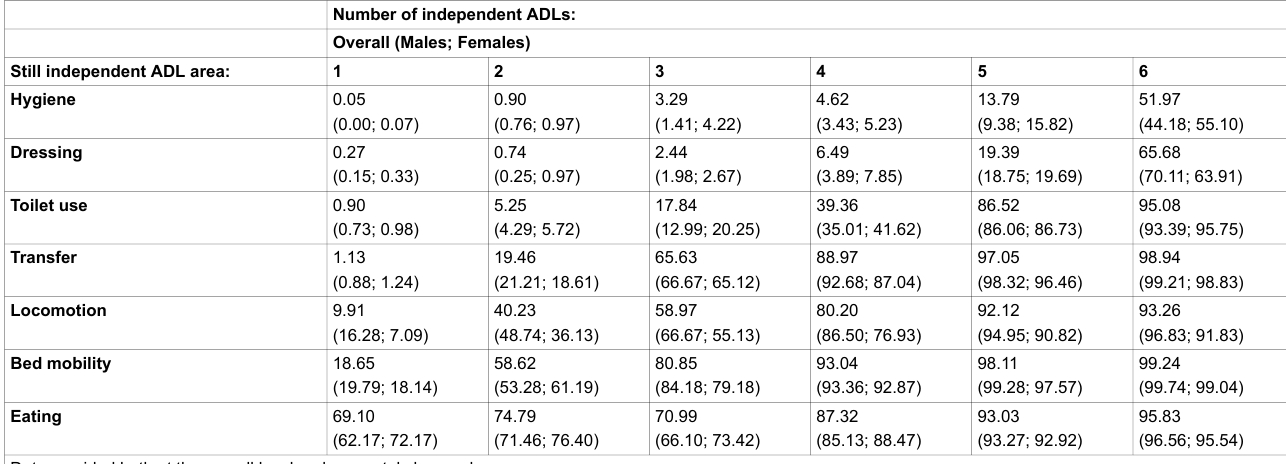
Table 4: Percentage of independent persons in each of the seven activities in function of the total number of independent activities. Number of independent ADLs: Overall (Males;